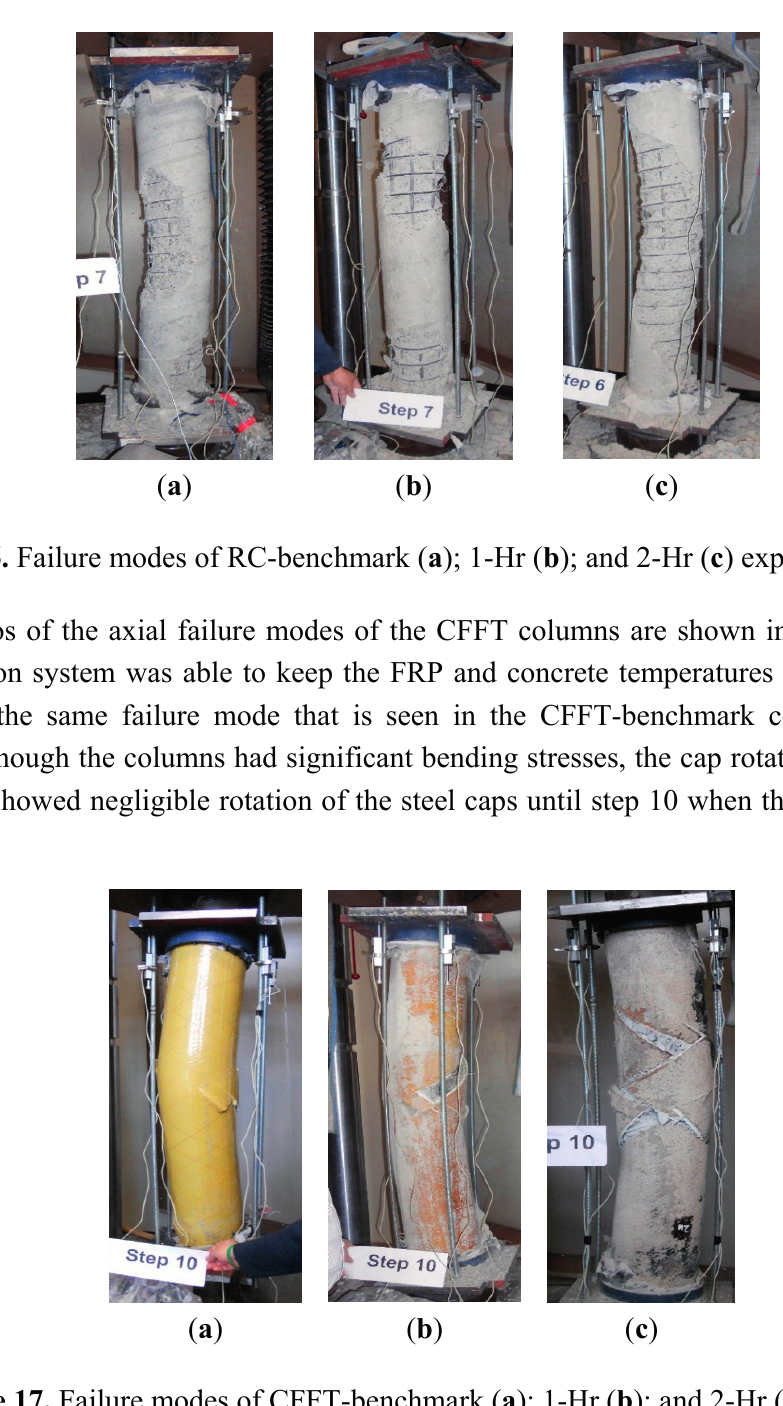
Figure 17. Failure modes of CFFT-benchmark ( a ); 1-Hr ( b ); and 2-Hr ( c )